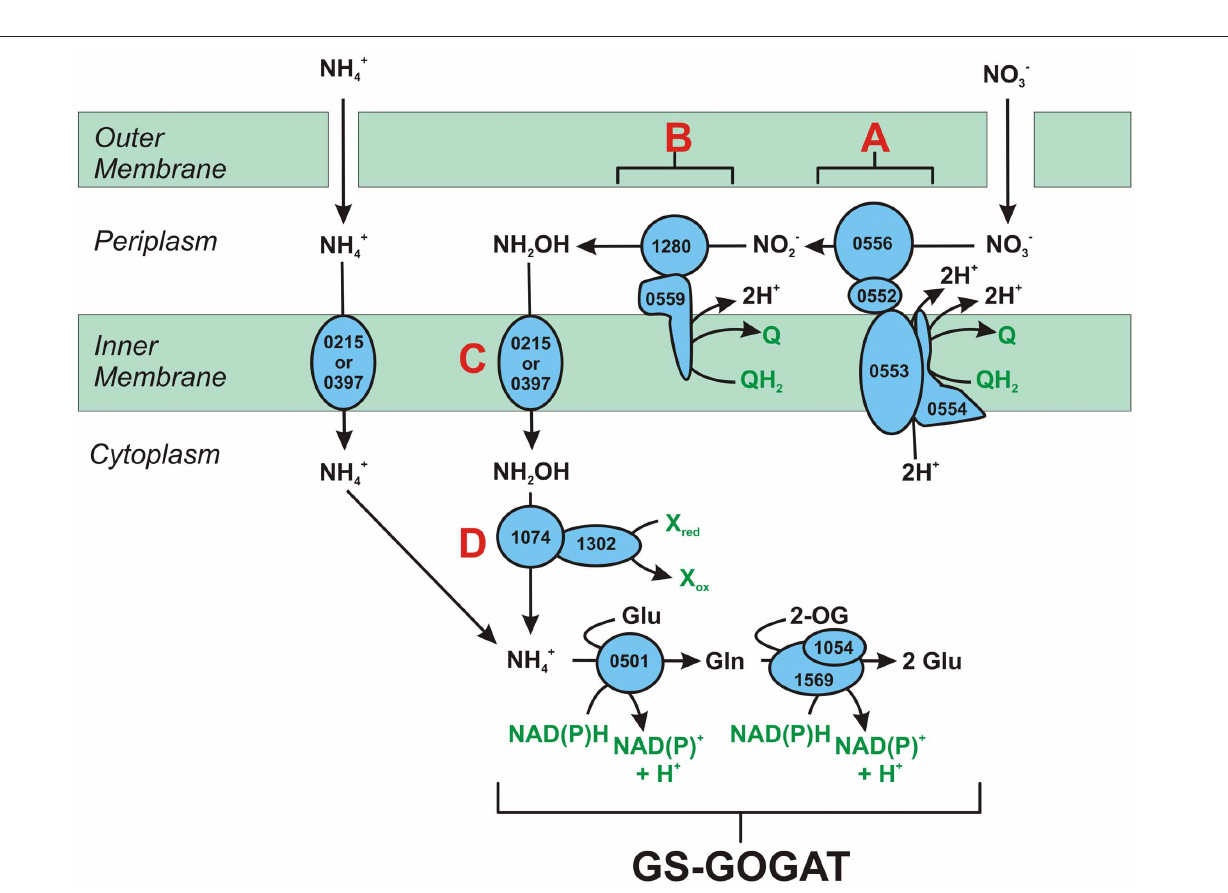
FIGURE 1 | The reverse-HURM pathway in N. profundicola . Individual steps are noted with capital letters in the figure. Numbers in the depicted proteins refer to locus tags from the AmH genome (i.e., 1280 = NAMH_1280 = HaoA). (A) Nitrate reduction by respiratory periplasmic nitrate reductase (NapABGH, 0556-53), (B) HURM (Hydroxylamine:Ubiquinone Redox Module) comprised of a reversely operating hydroxylamine oxidoreductase (HaoA, 1280) functioning as an ocataheme nitrite reductase, that produces hydroxylamine utilizing